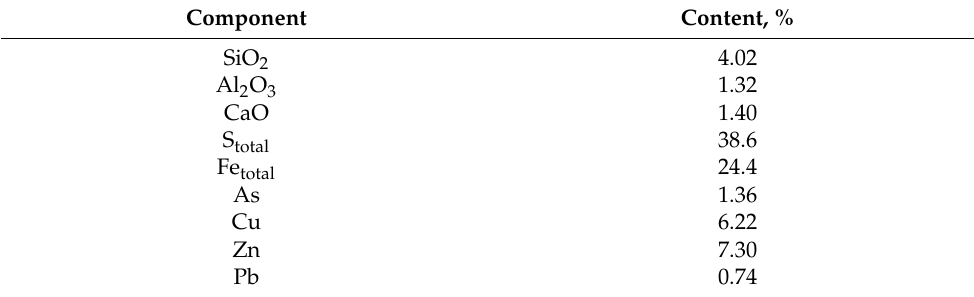
Table 1. Main elemental contents in the concentrate